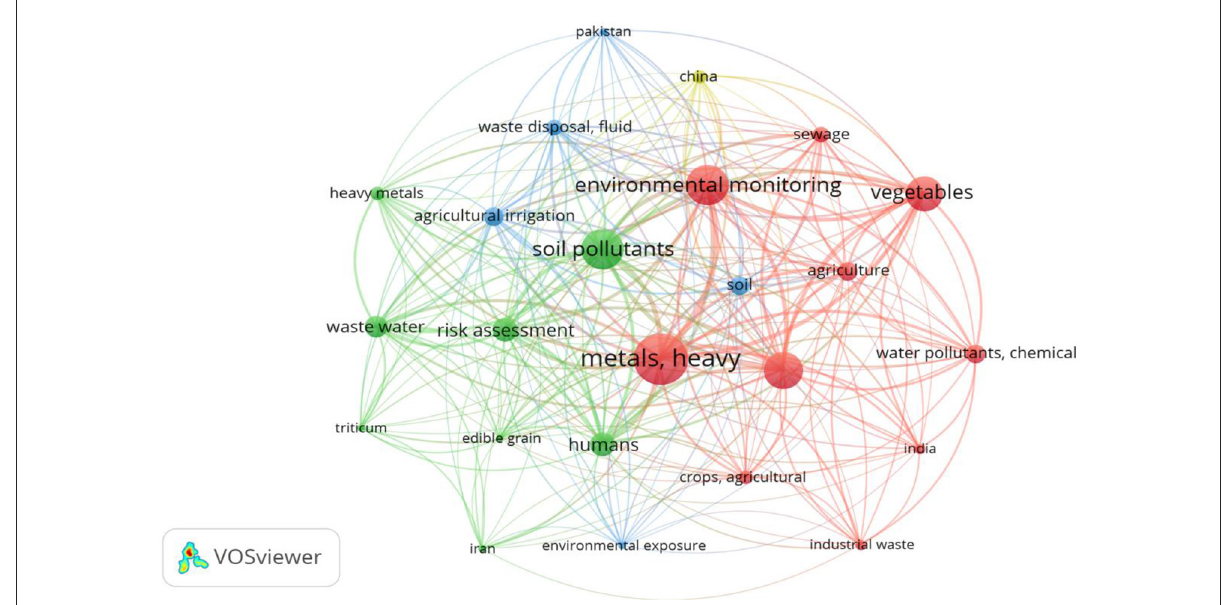
FIGURE2 Bibliometric analysis of the co-occurrence of keywords in the selected publications.